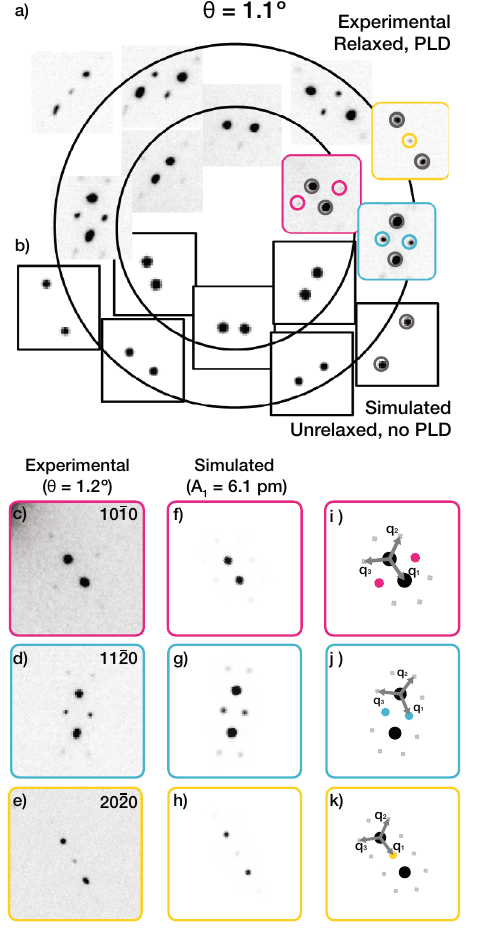
Fig. 2 | Torsional periodic lattice distortion (PLD) model. a Electron diffraction of TBG ( θ =1.1 ∘ ) displays superlattice peak complexes in addition to two sets of Bragg peaks, marked by gray circles. b The simulated diffraction pattern of unre- laxed TBG only shows two sets of Bragg peaks. Multislice simulation ( f – h ) for PLD with only a single harmonic ( A 1 =6.1pm) matches greatly with the experimental data ( c – e ). i – k Schematic illustration shows PLD wave vectors ( q i ’ s) in relation to Bragg and superlattice peaks.